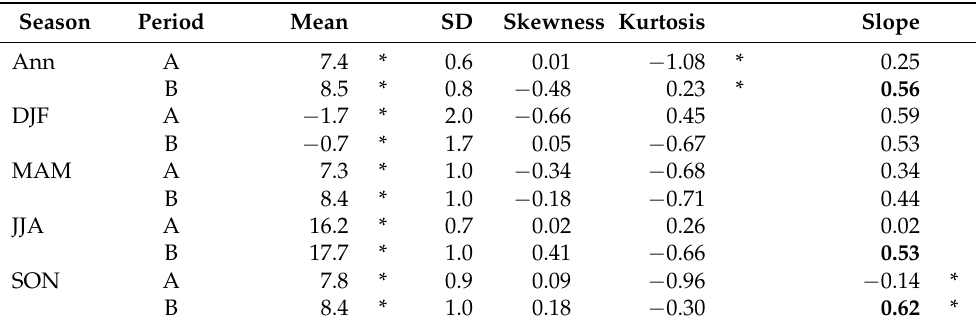
Table 3. Selected statistical characteristics of mean annual (Ann) and seasonal (DJF, MAM, JJA, and SON) temperature series in the Czech Republic in the 1961–1990 (A) and 1991–2020 (B) periods: means and standard deviations (SD) are in ◦ C, linear trends in ◦ C/10 years (in bold statistically significant at the 0.05 significance level). An asterisk * indicates statistically significant differences of a given characteristic between two 30-year periods. Season